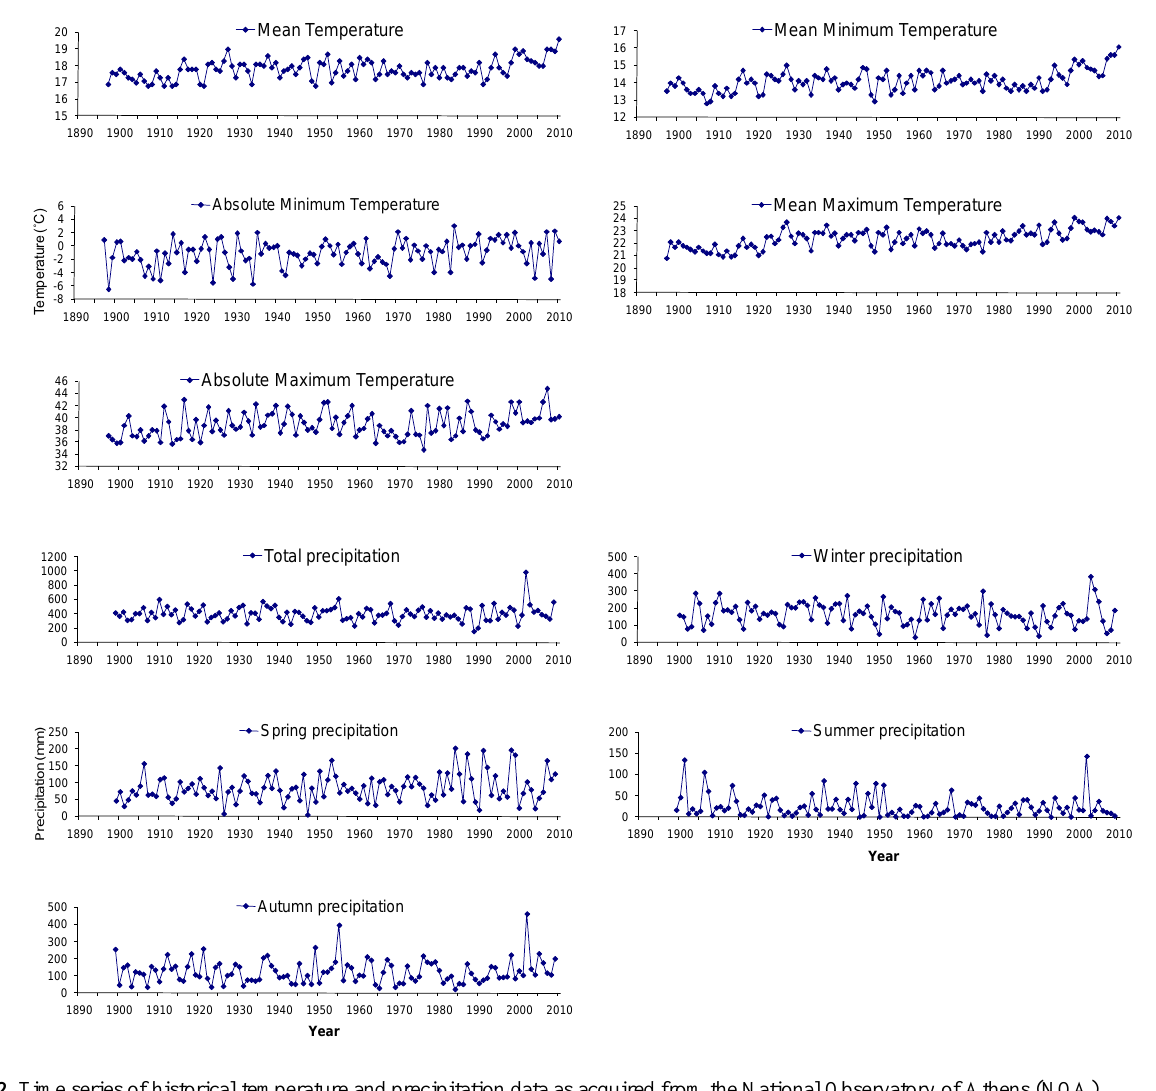
values, within the 95 % confidence intervals (0) are also